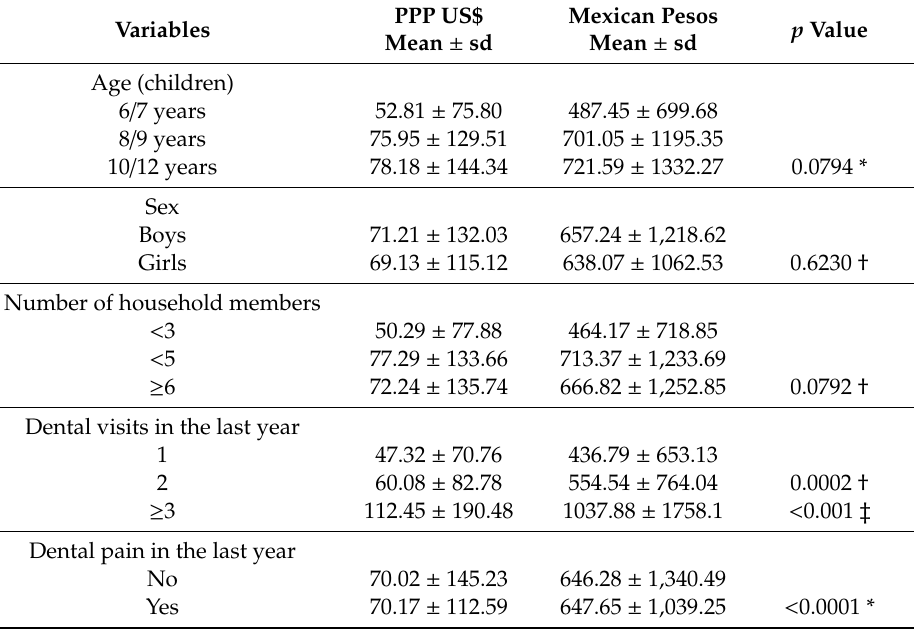
Table 4. Out-of-pocket expenditures for dental care according to the sociodemographic and health characteristics of the schoolchildren, International Dollars and Mexican pesos,